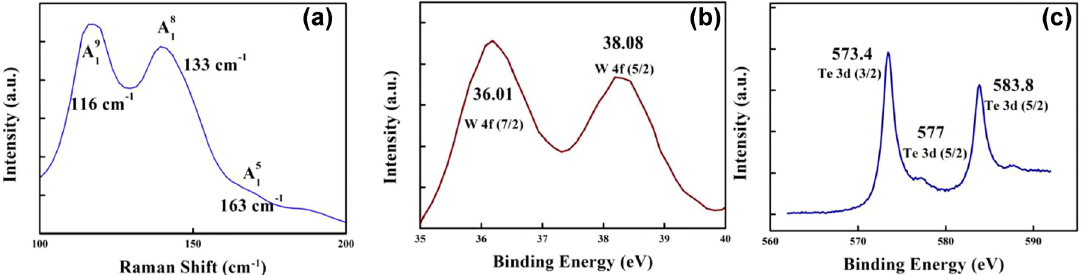
device characterization. (a) Raman spectra. (b) and (c) XPS Figure 2: WTe 2